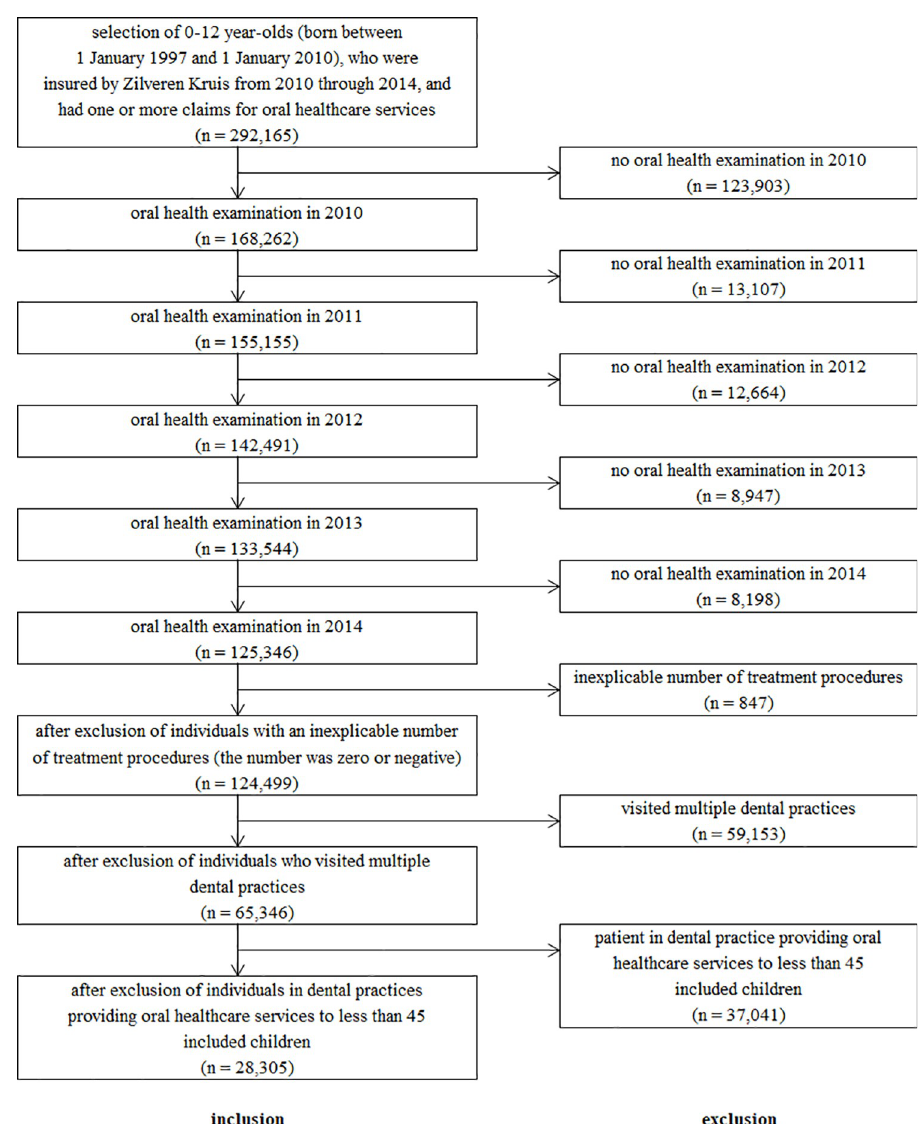
Fig 1. Flow diagram of the selection of the study